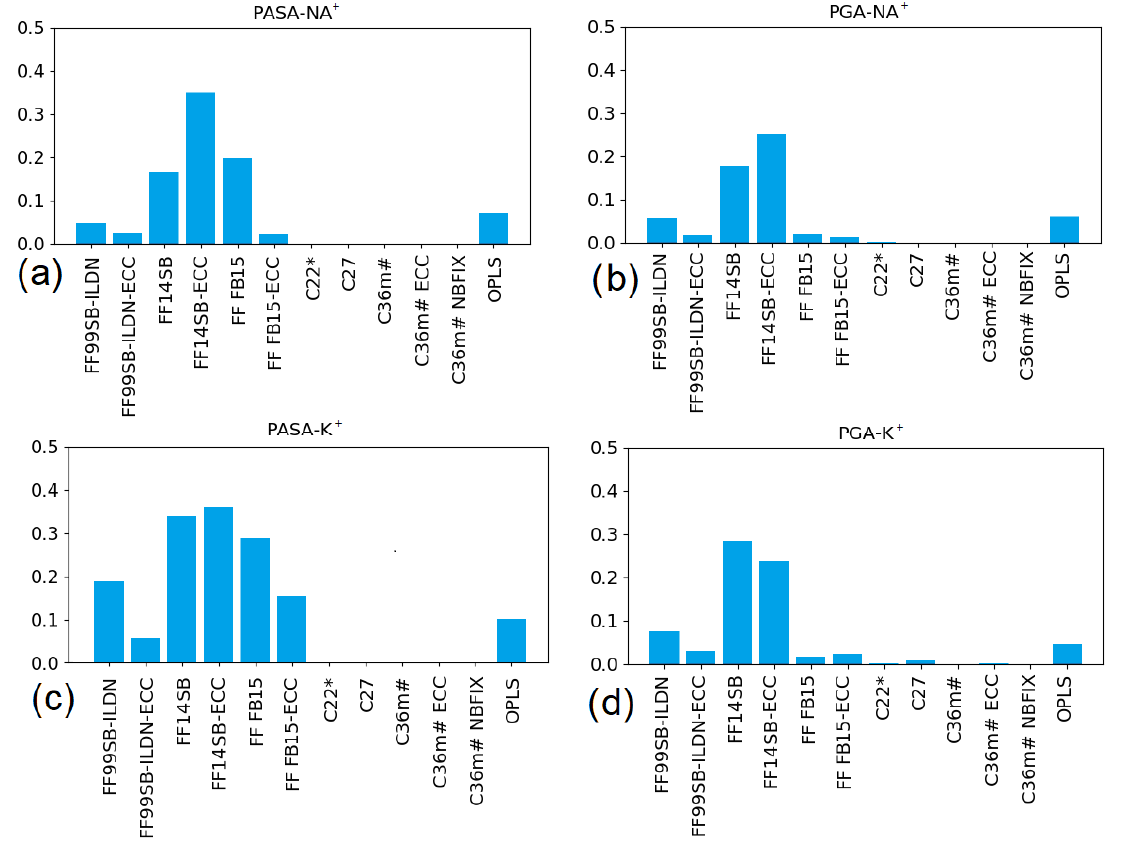
Figure 10. Fractions of PASA ( a , c ) and PGA ( b , d ) monomers included in the β -conformational sequences (more than 3 monomers).